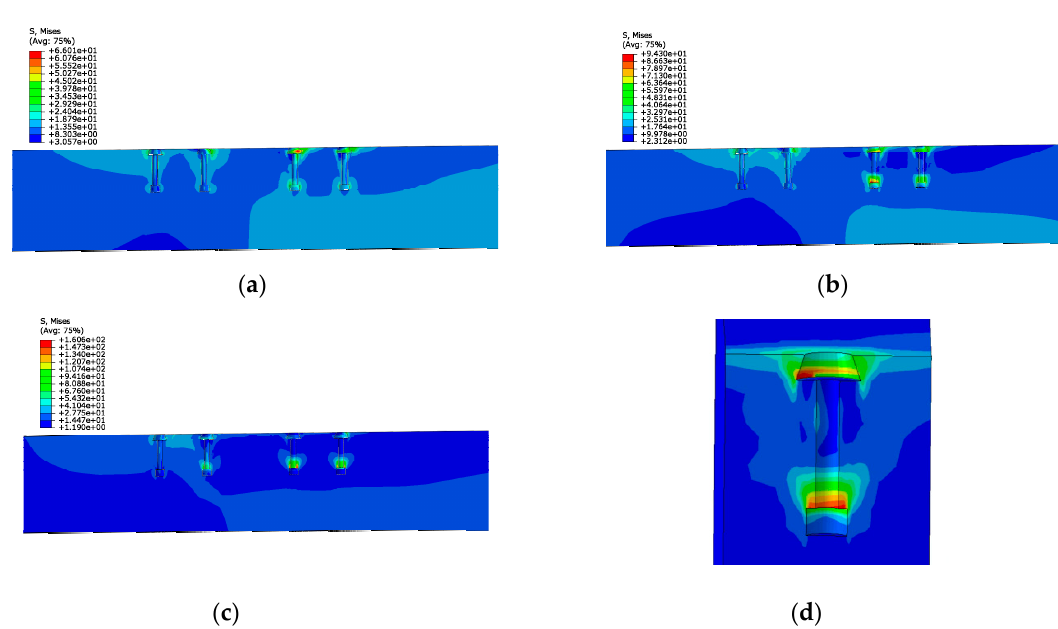
Figure 28. Stress distribution in the concrete. ( a ) Elastic stage; ( b )Yield stage; ( c ) Ultimate stage; ( d ) Details.